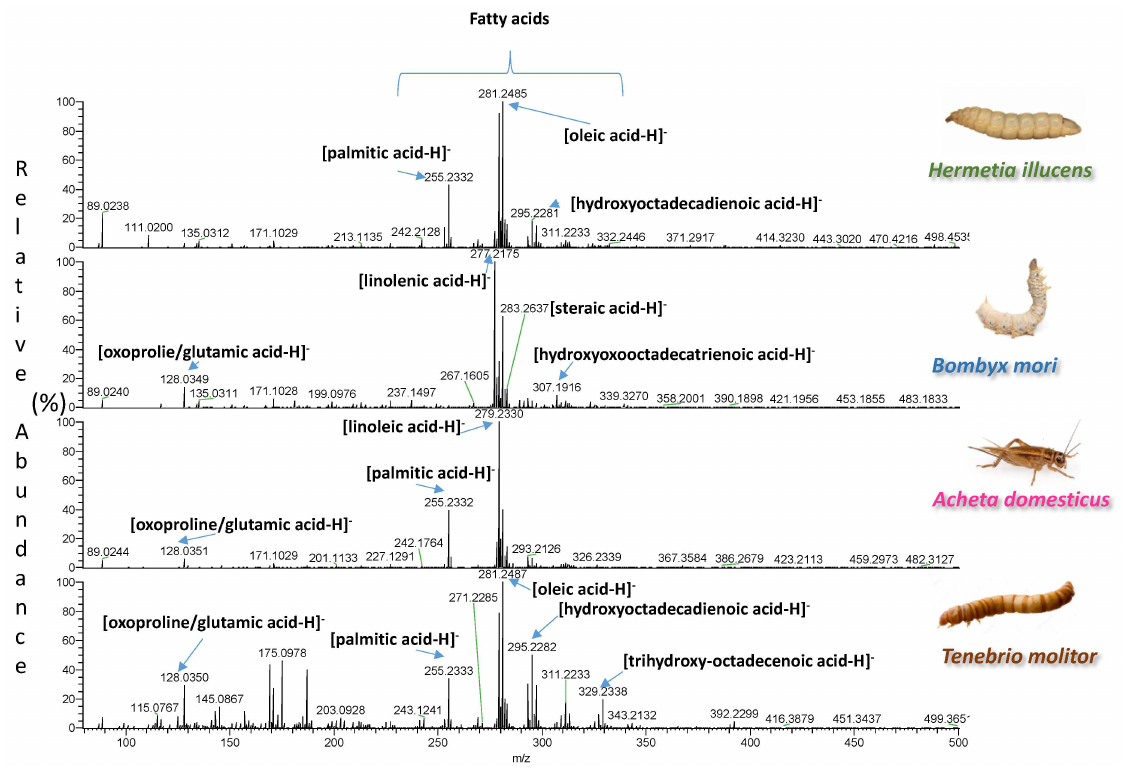
Figure 1. DART-HRMS spectra of the extracts B of edible powders of Hermetia illucens , Bombyx mori , Acheta domesticus , and Tenebrio molitor acquired in negative ion mode. The acquired spectra are zoomed in, to facilitate the visualization of the most informative m/z range between 75 – 500 Da.